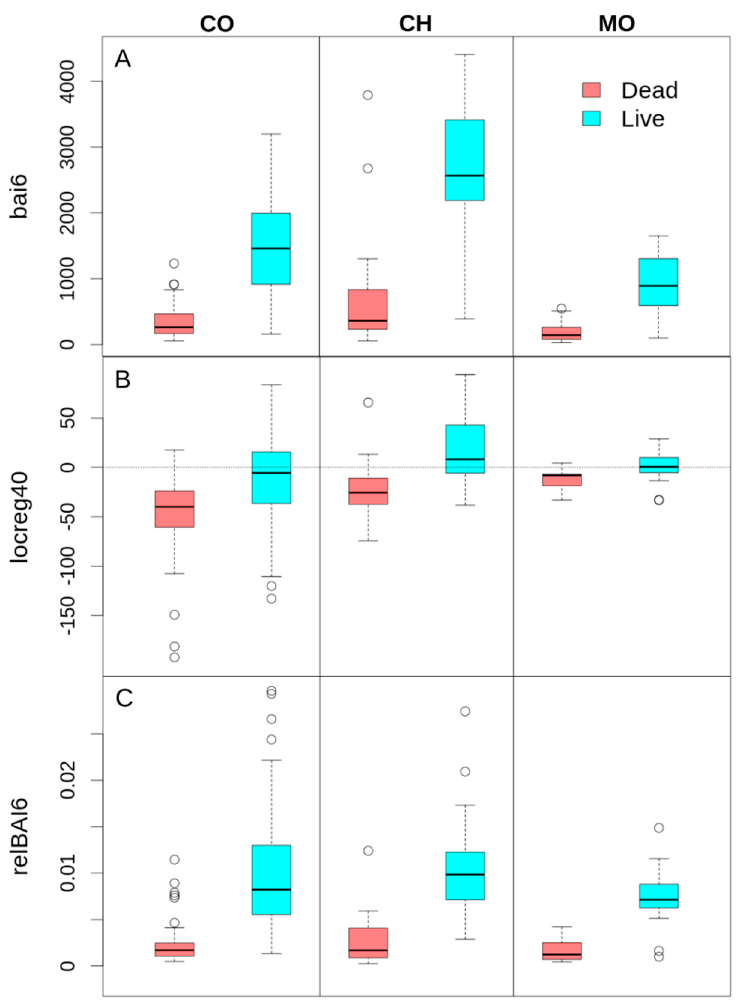
Figure 5. Comparison between growth rate and growth trend variables for dead and live trees. ( A ) Mean BAI for the last six years (bai6); ( B ) BAI trend for the last 40 years (locreg40), and ( C ) average BAI for the last six years relative to the total basal area (relBAI6).